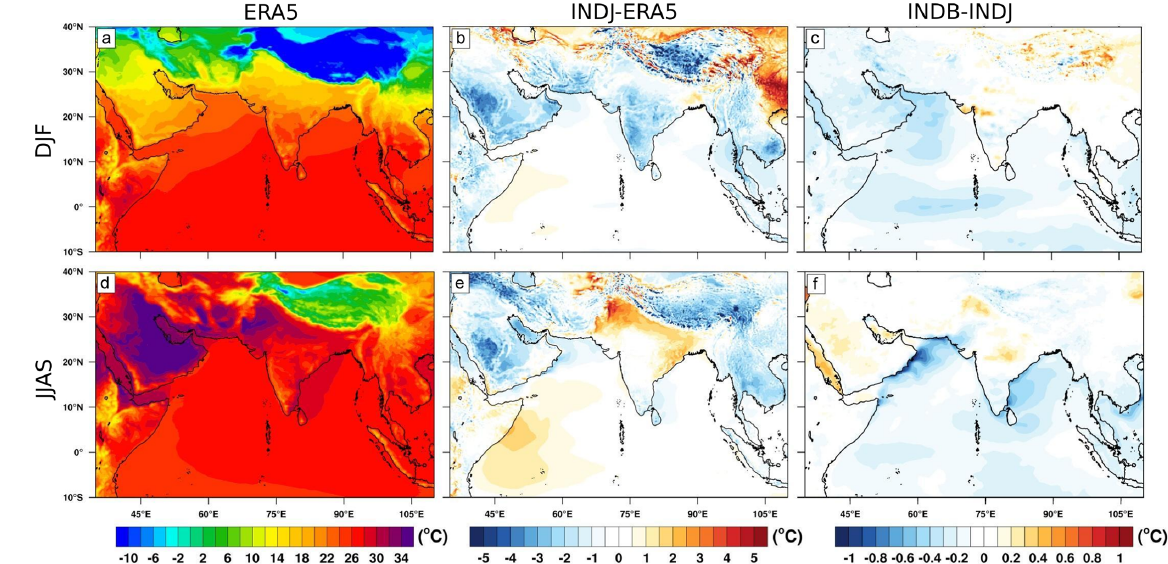
Figure 14. DJF (upper row) and JJAS (lower row). (a, d) 2m temperature ERA5 climatology. (b, e) Bias for the experiment INDJ; (c, f) INDB–INDJ difference.